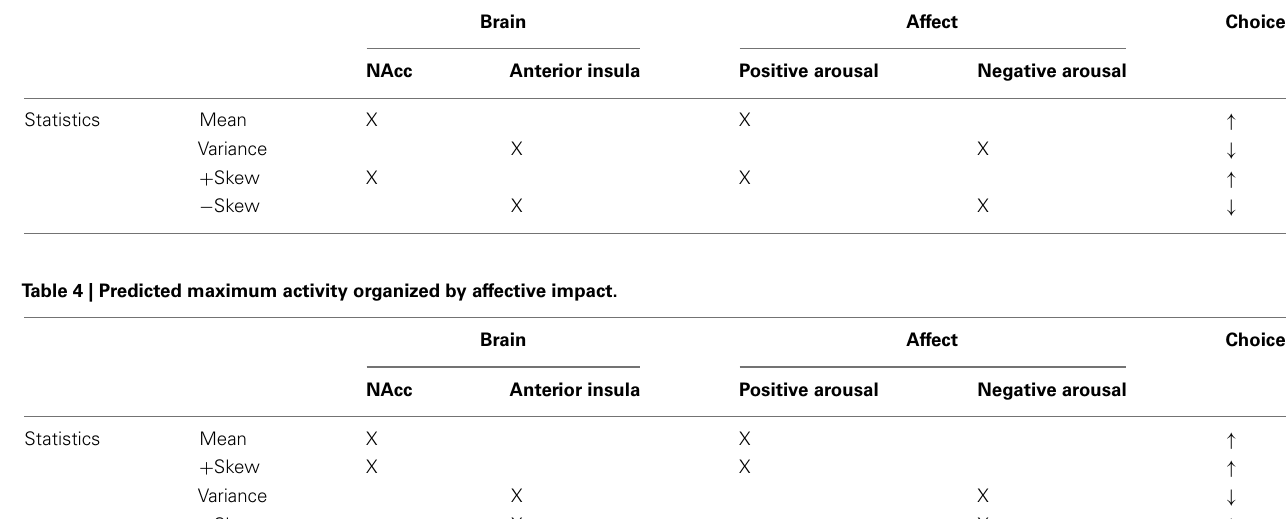
Table 3 | Predicted maximum activity organized by statistical moments (lower to higher order).